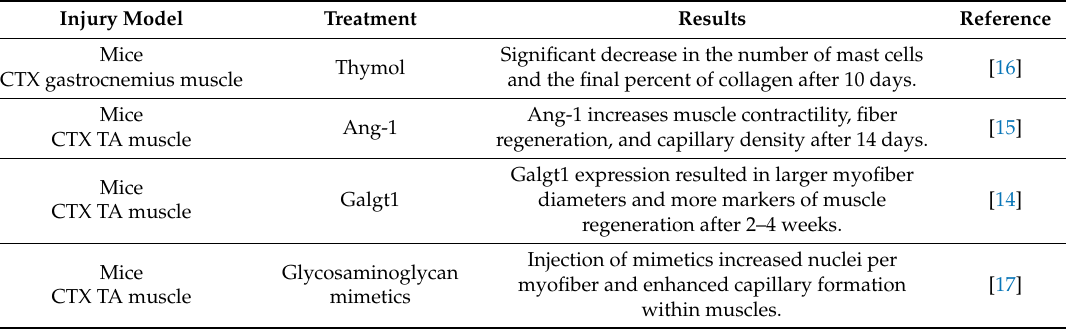
Table 1. Summary of recent studies utilizing cardiotoxin (CTX) injuries to study skeletal muscle tissue regeneration.